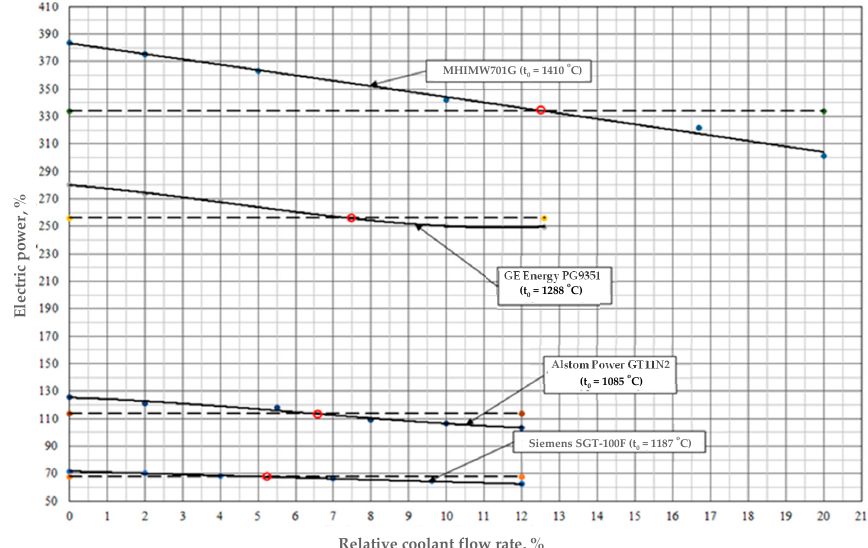
Figure 3. Dependences of changes in the electrical efficiency of GTU with different levels of power 199 and temperatures on the relative flow rate of the coolant.